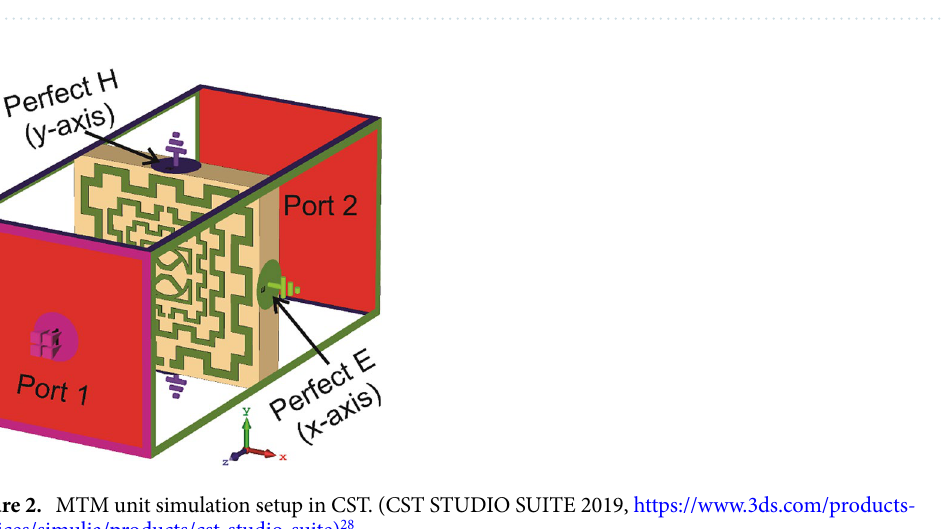
Figure 1. Geometric structure of the proposed MTM unit cell. (CST STUDIO SUITE 2019, https:// www. 3ds. com/ produ cts- servi ces/ simul ia/ produ cts/ cst- studio- suite) 28 .